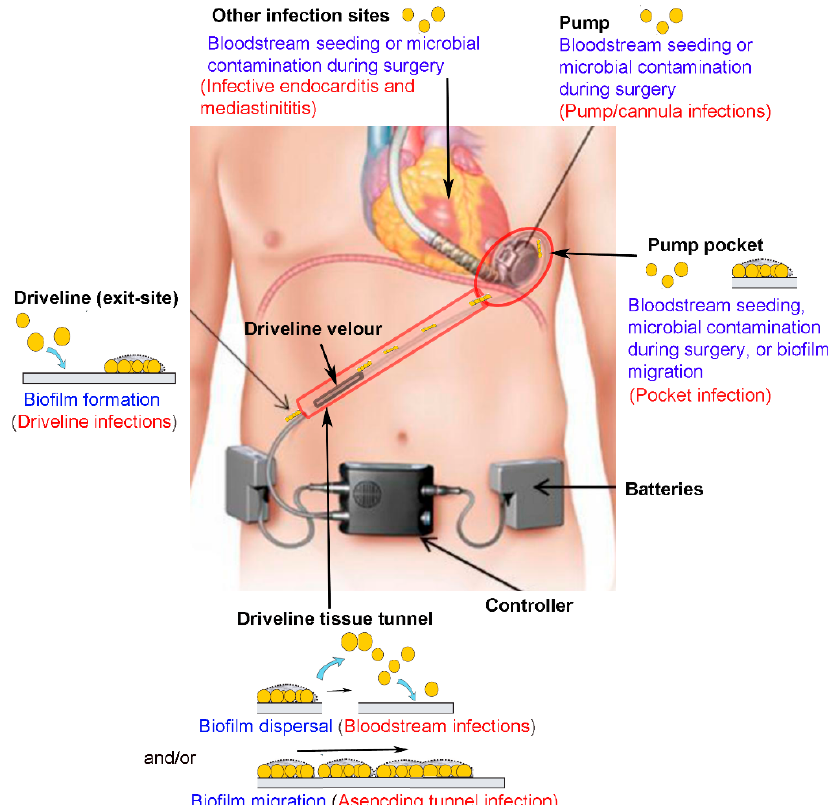
Figure 1. Ventricular assist device (VAD)-specific and VAD-related infections. Microorganisms cause infections (text in red) at different anatomic sites where VAD components are placed (text in black) via three routes (text in blue). Microorganisms form biofilms on the driveline at the skin exit-site, causing superficial driveline infections. Microbial dispersal from established biofilms often results in bloodstream infections. Migration of biofilms along the driveline tissue tunnel leads to ascending tunnel infection or pump pocket infection (route 1). Intraoperative microbial contamination of VAD components (route 2), or hematogenous seeding from other infection sites (route 3) can also lead to pump pocket infection, pump/cannula infections, or other VAD-related infections.